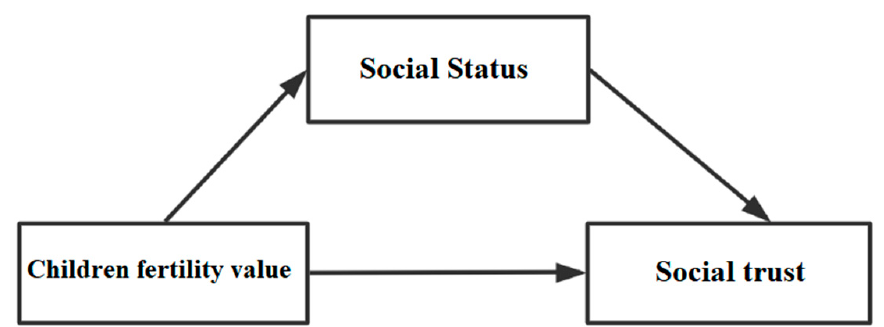
Figure 3. Social status–mediated effect model of fertility value influencing social trust.